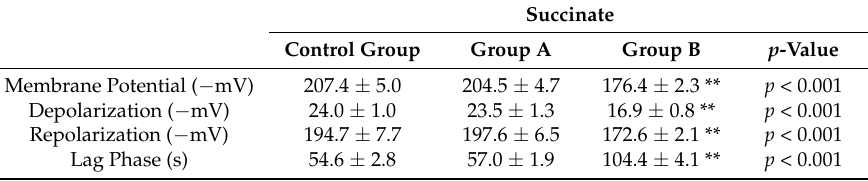
Table 1. The effects of I/R with or without BBR (18.6 mM) supplementation on hepatic mitochondrial membrane potential and lag phase. Mitochondria were isolated from animals sacrificed after 12 h of hepatic exposure to preservation solution and 1 h of reperfusion, as described in the Materials and Methods Section. Control animals were sham operated. Δψ was evaluated with a TPP + -sensitive electrode. Mitochondria isolated from the I/R group (Group B) had a clear loss of activity compared to the control group, while the supplementation with BBR (Group A) was sufficient to prevent said alterations. Data are the means ± SEM of at least 2 different experiments, performed with 10 animals/group. Statistical significance: p < 0.05; ** indicates a statistically-significant difference ( p < 0.01) against the control group.